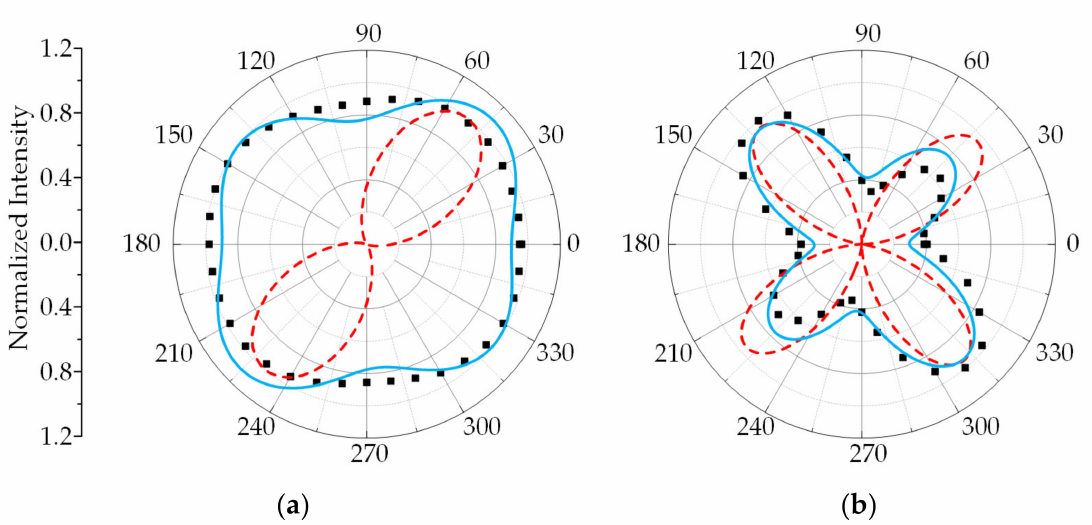
Figure 8. Comparison of experimental results (black solid points) and theoretical results (red solid line) without considering the effect of N.A. under the vertical backscattering configuration in the ( a ) HH case and ( b ) HV